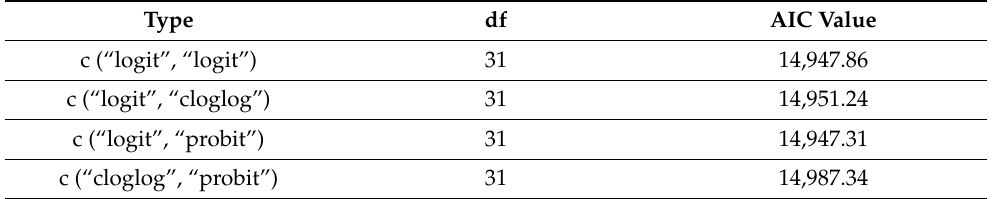
Table 4. The AIC results of the link